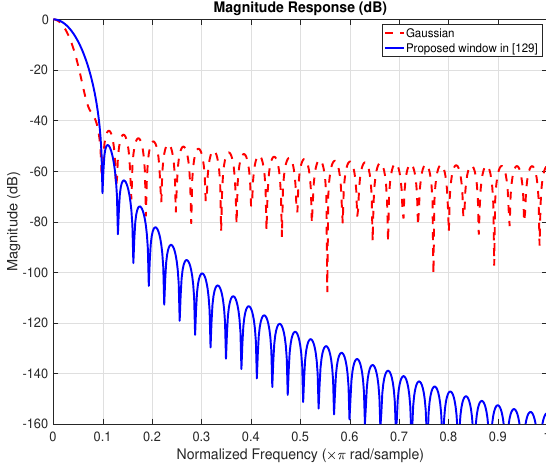
Figure 5. Frequency responses of Gaussian window and the new window proposed in